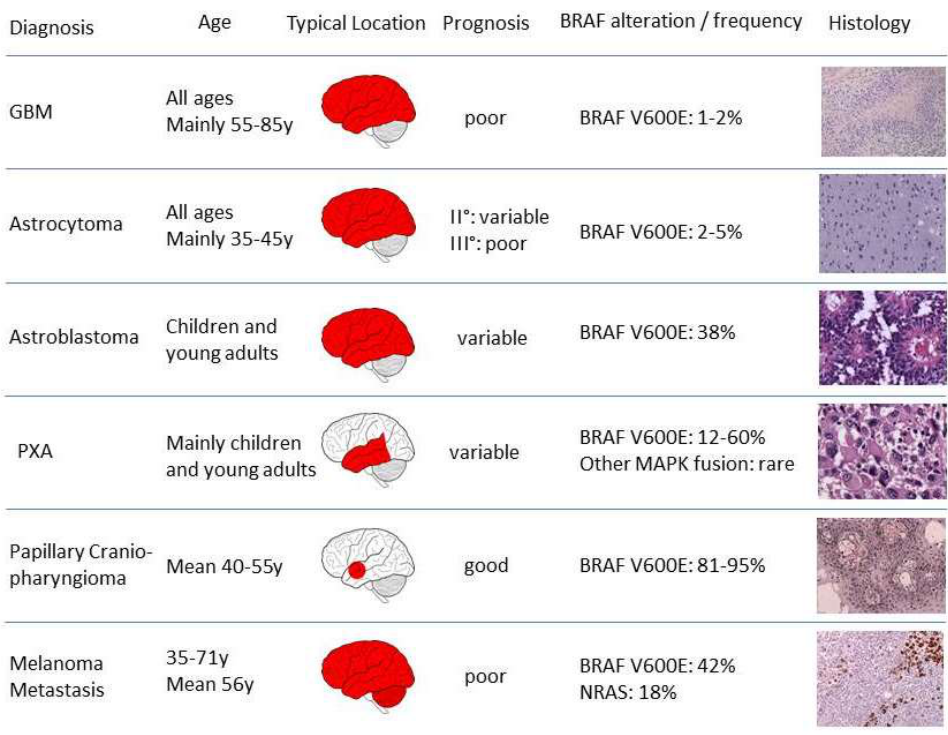
Figure 2. Distribution of BRAF alterations in adult brain tumors (GBM: glioblastoma, PXA: pleomorphic xanthoastrocytoma).